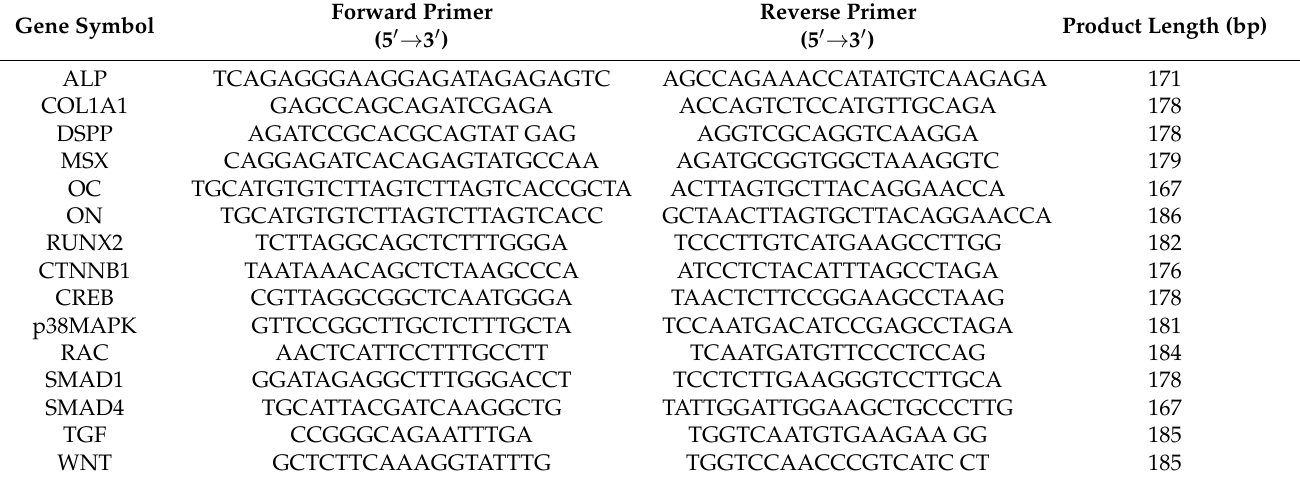
Table 1. Human primer